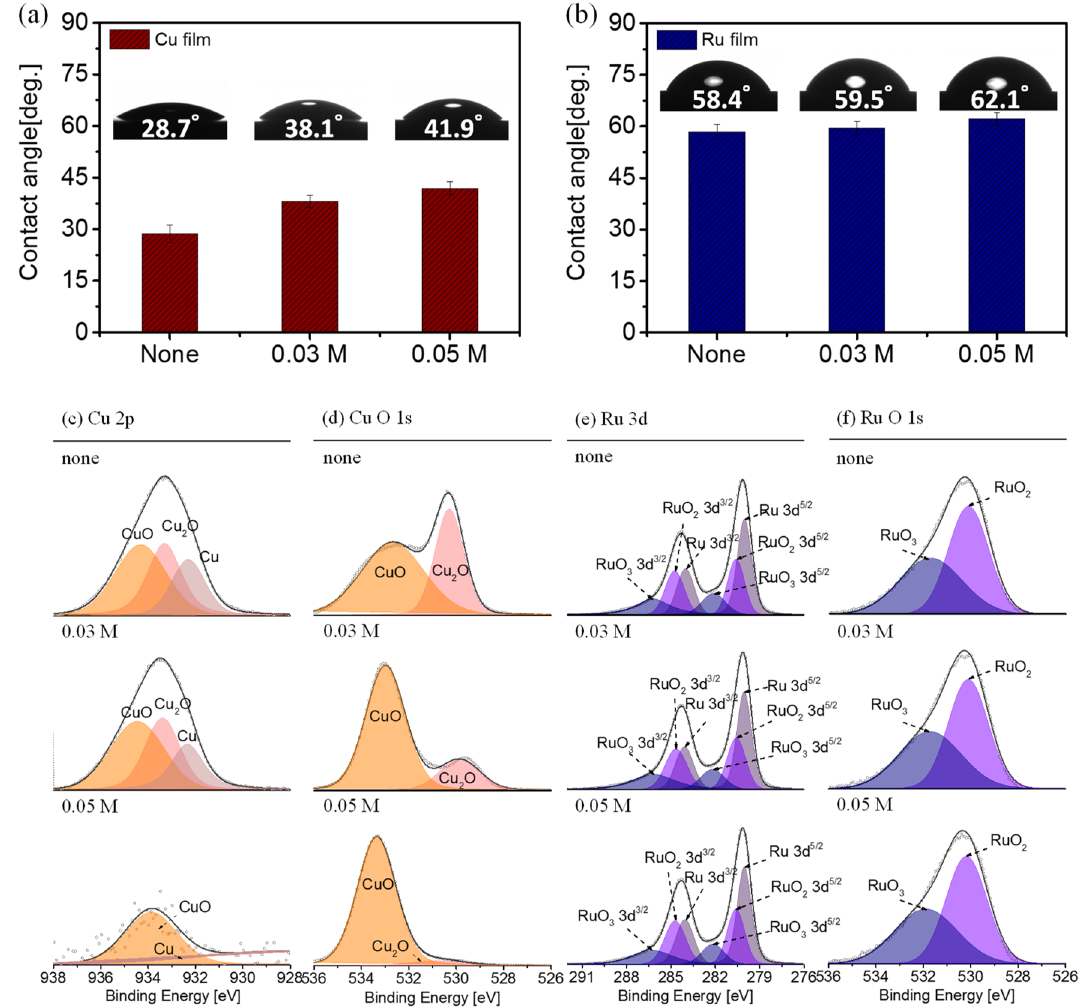
Figure 3. Interfacial interaction behaviour analysis between Cu/Ru films and nicotinic acid inhibitor. (a,b) Contact angle measurement of Cu and Ru films after dipping as a function of inhibitor concentrations at pH 10. (c–f) X-ray photoelectron spectroscopy (XPS) results for (c) Cu 2p, (d) Cu O1s, (e) Ru 3d, and (f) Ru O1s as a function of inhibitor concentrations at pH and 285.0 eV. Because RuO 2 ∙H 2 O is a metallic oxide with a partially filled conduction band, the core–hole cou- pling may occur on this surface 28 . Thus, RuO 3 is considered present with the bulk phase of RuO 2, and the binding energy peaks at 282.3 eV and 286.5 eV, respectively. Meanwhile, the binding energy peaks for RuO 2 and RuO 3 appear at 529.2 eV and 530.7 eV in Ru O1s spectra 29,30 . No change with nicotinic acid concentration was observed in the case of both Ru 3d (Fig. 3e) and Ru O1s (Fig. 3f) XPS results. In other words, the above results mean that nicotinic acid was barely adsorbed on the Ru film. These results correspond with the contact angle measurements. Electrochemical interaction evaluation between Cu/Ru films and nicotinic acid inhibitor. For analysis on electrochemical properties, the potentiodynamic plots and Nyquist plots are evaluated. The corro- sion potentials (E corr ) and corrosion currents (I corr ) of the Cu and Ru films under the different nicotinic acid concentrations are noted in Fig. 4a–c and Table 1. As shown in Fig. 4a–c, the Tafel curves of Cu and Ru films were evaluated through potentiodynamic polarization measurements. The potential difference between Cu and Ru films decreased from 0.49 to 0.09 V as inhibitor concentrations increased from 0 to 0.05 M. The galvanic cor- rosion occurs in the heterojunction of Cu/Ru films because two metal films have different potentials. In Cu film, oxidation reactions that donate electrons occur (as an anodic site), while reduction reactions occur in the Ru film that accepts electrons (as a cathodic site). Therefore, by controlling the potential of both films by reducing the gap of potential difference, the redox reaction can be suppressed, resulting in galvanic corrosion prevention. The experimental results in Fig. 4c show that the potential difference between Cu and Ru is significantly reduced to 0.09 V, indicating the galvanic corrosion between Cu and Ru films was suppressed. On the other hand, the Cu film potential change is 0.63 V (from −0.27 V to 0.36 V), more significant than that of Ru film (0.23 V, from 0.22 V to 0.45 V). In both cases, adsorption of nicotinic acid tended to form an inhibitor passivation layer lead-